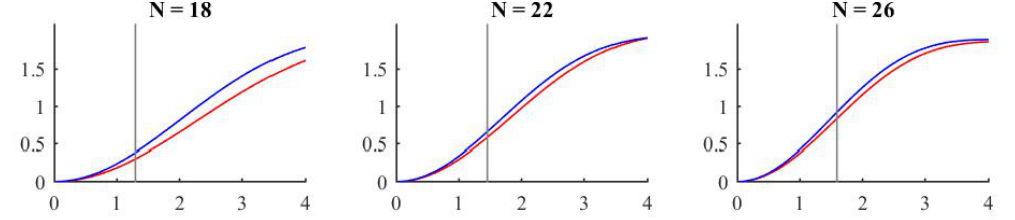
Figure 25 . We compare the expectation value of (cid:0)h [ S 1 ( t ) ; S 2 (0)] 2 i in the thermal state (blue) and pure state (red). The scrambling time is designated by the vertical line.